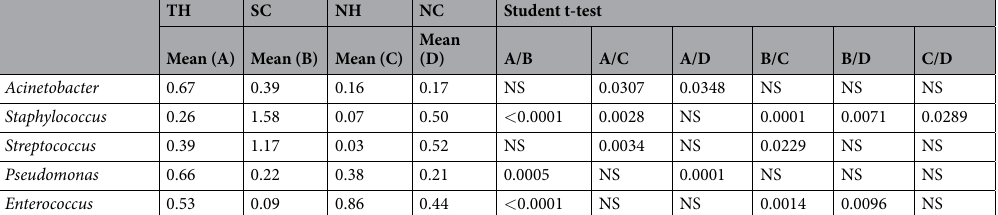
Table 4. Results of Student’s t-test examining the bacterial cell abundances (%) in the four healthcare institutes. NS, not significant ( p >